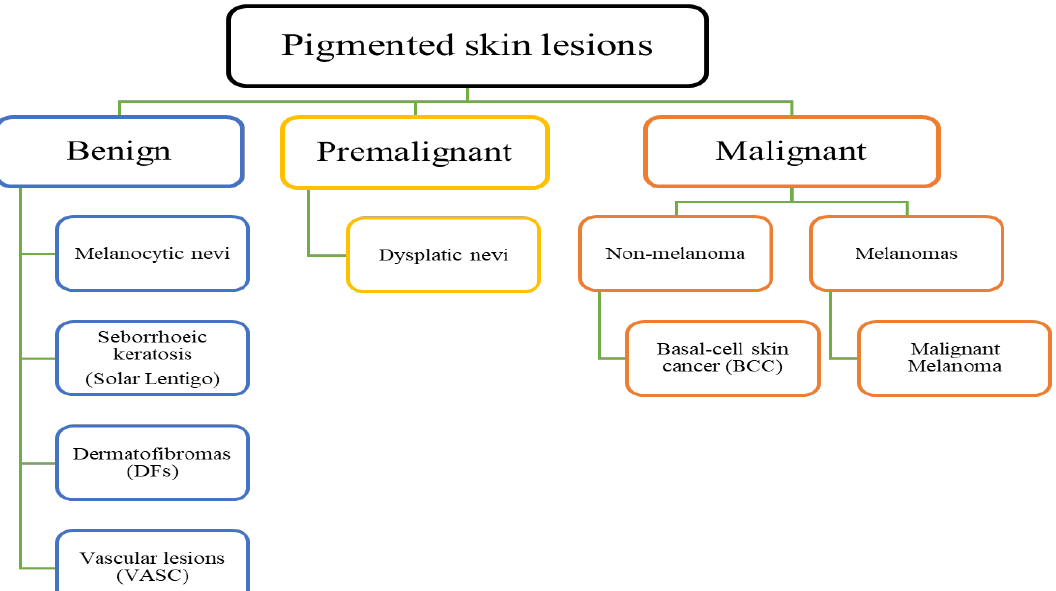
Figure 1. The pigmented skin lesions at different stages.